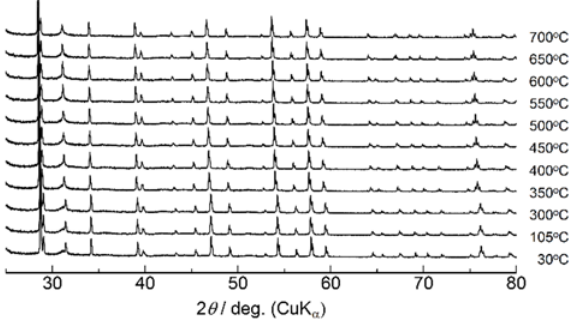
Figure 6. X ‐ ray diffraction patterns of Ca 1 − x K x WO 4 − x/2 ( x = 0.1) measured at high temperatures up to 700 °C.